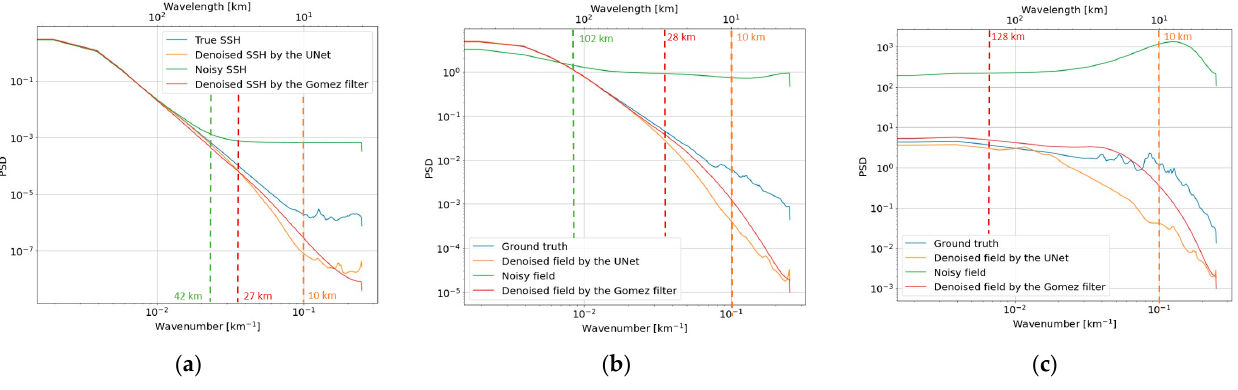
Figure 10. PSD of ( a ) true SSH (blue), noisy SSH (green), SSH denoised by the U-Net (orange) and SSH denoised by the Gomez filter (red) and the PSD of the associated first ( b ) and second ( c ) derivatives. The PSD is computed from the average of each along-track PSD over the eNATL60 domain and on the test dataset (year 2010). The vertical dotted lines are computed from Figure 11 and indicate the resolved wavelengths.